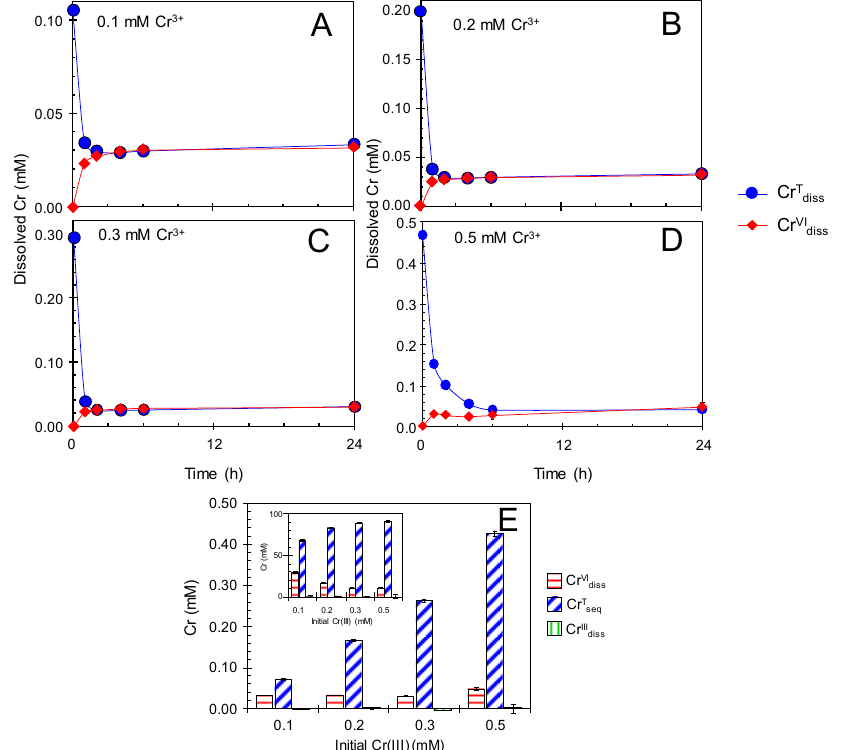
Figure 4. Single treatment of newly formed biogenic manganese oxides (BMOs; 1 mM as Mn) with 0.1–0.5 mM Cr(NO 3 ) 3 under anaerobic conditions at pH 6.0 (100 mM MES buffer). ( A – E ) Concentrations of total Cr dissolved (Cr Tdiss ) and Cr(VI) dissolved (Cr VIdiss ). Initial Cr(NO 3 ) 3 concentrations were: ( A ) 0.1 mM, ( B ) 0.2 mM, ( C ) 0.3 mM, and ( D ) 0.5 mM. ( E ) Concentrations (inset: percentages) of total Cr sequestered (Cr Tseq ), Cr(VI) dissolved (Cr VIdiss ), and Cr(III) dissolved (Cr IIIdiss ) after the treatments. Data are shown as mean ± standard deviation (n = 3).